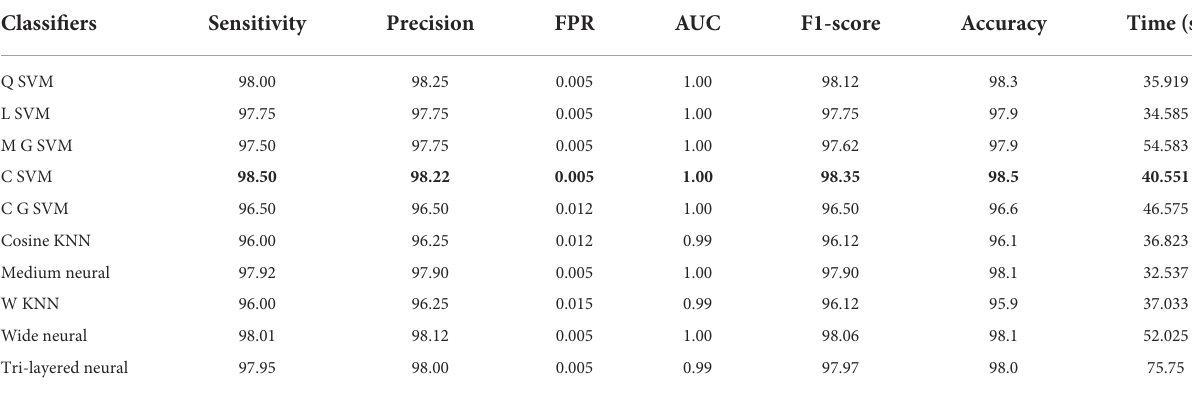
TABLE 7 Proposed features optimization method results on chest X-ray